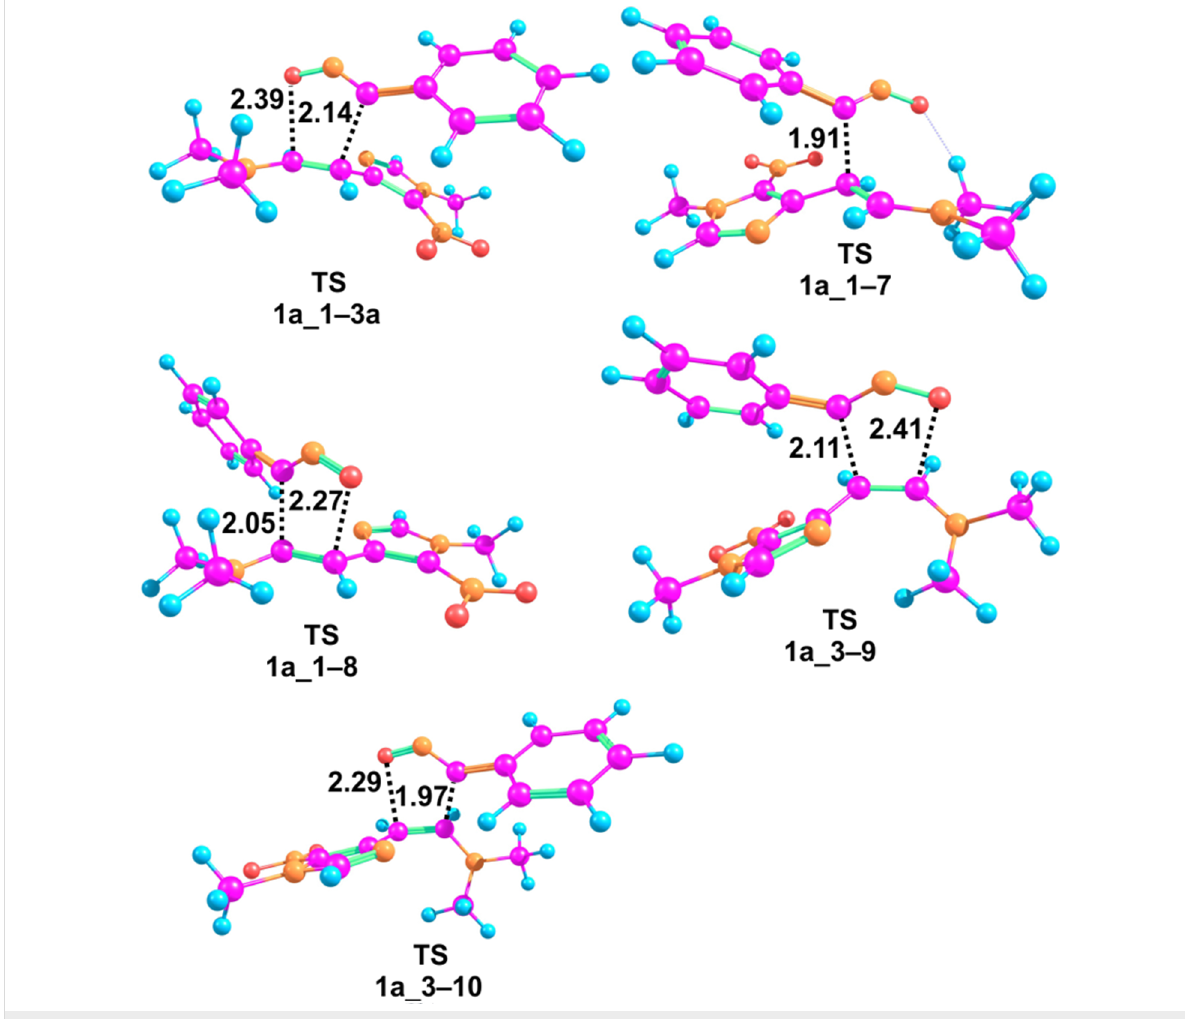
Figure 6: Structures of the localized transition states. Lengths of the forming bonds are given in Å.